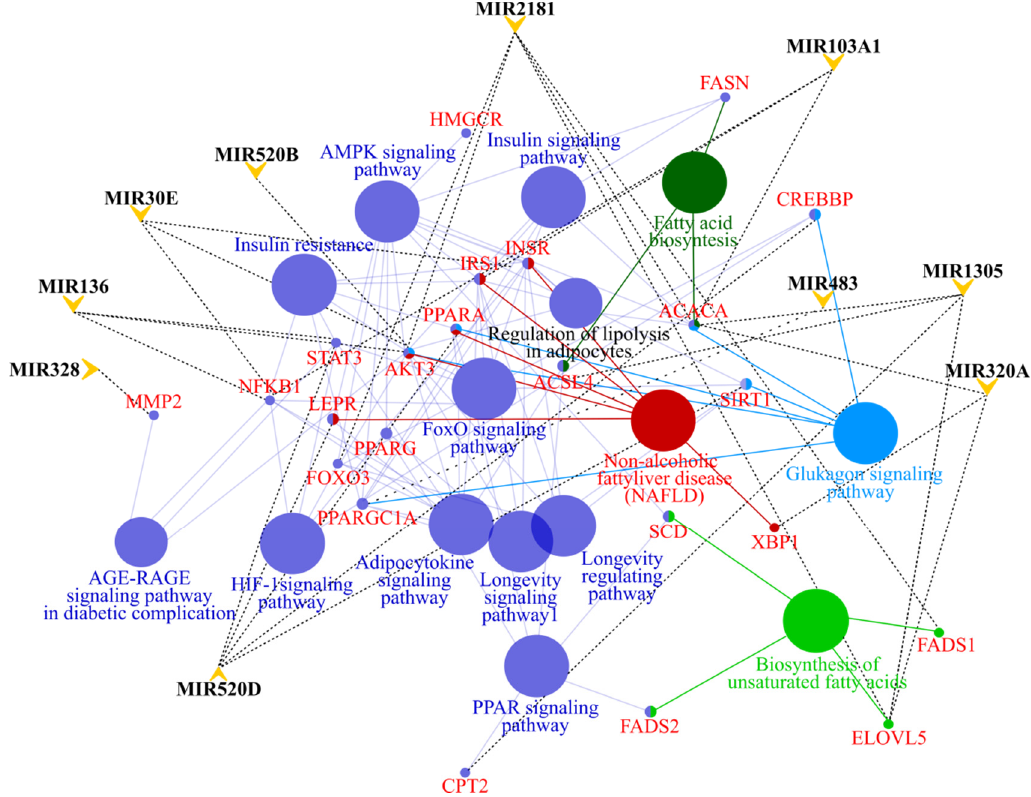
Figure 4. Interactions of microRNAs with gene pathways. The known miRNA gene targets were extracted using the mirPath v.3 DIANA TOOLS. The miRNA-gene interaction network was generated through Cytoscape with ClueGO.